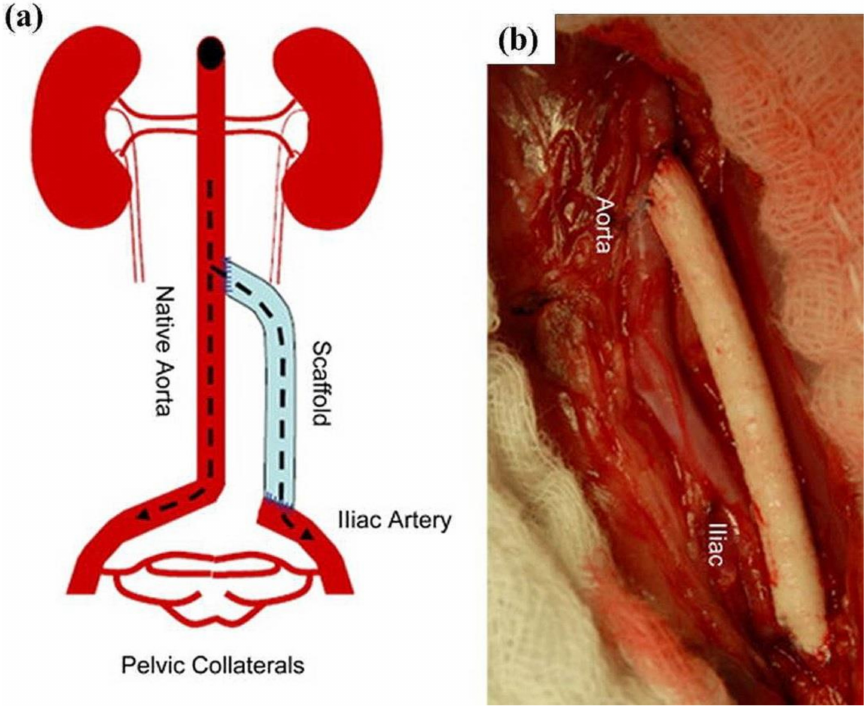
Figure 19. Rabbit aortoiliac bypass procedure with a composite graft made of electrospun polycaprolactone (PCL)/collagen. ( a ) The grafts were sutured end-to side between native aorta and native iliac artery, with the ligation of proximal iliac artery to redirect flow into the composite graft; ( b ) a representative operative image [215]. Reproduced with permission from ref. [215].